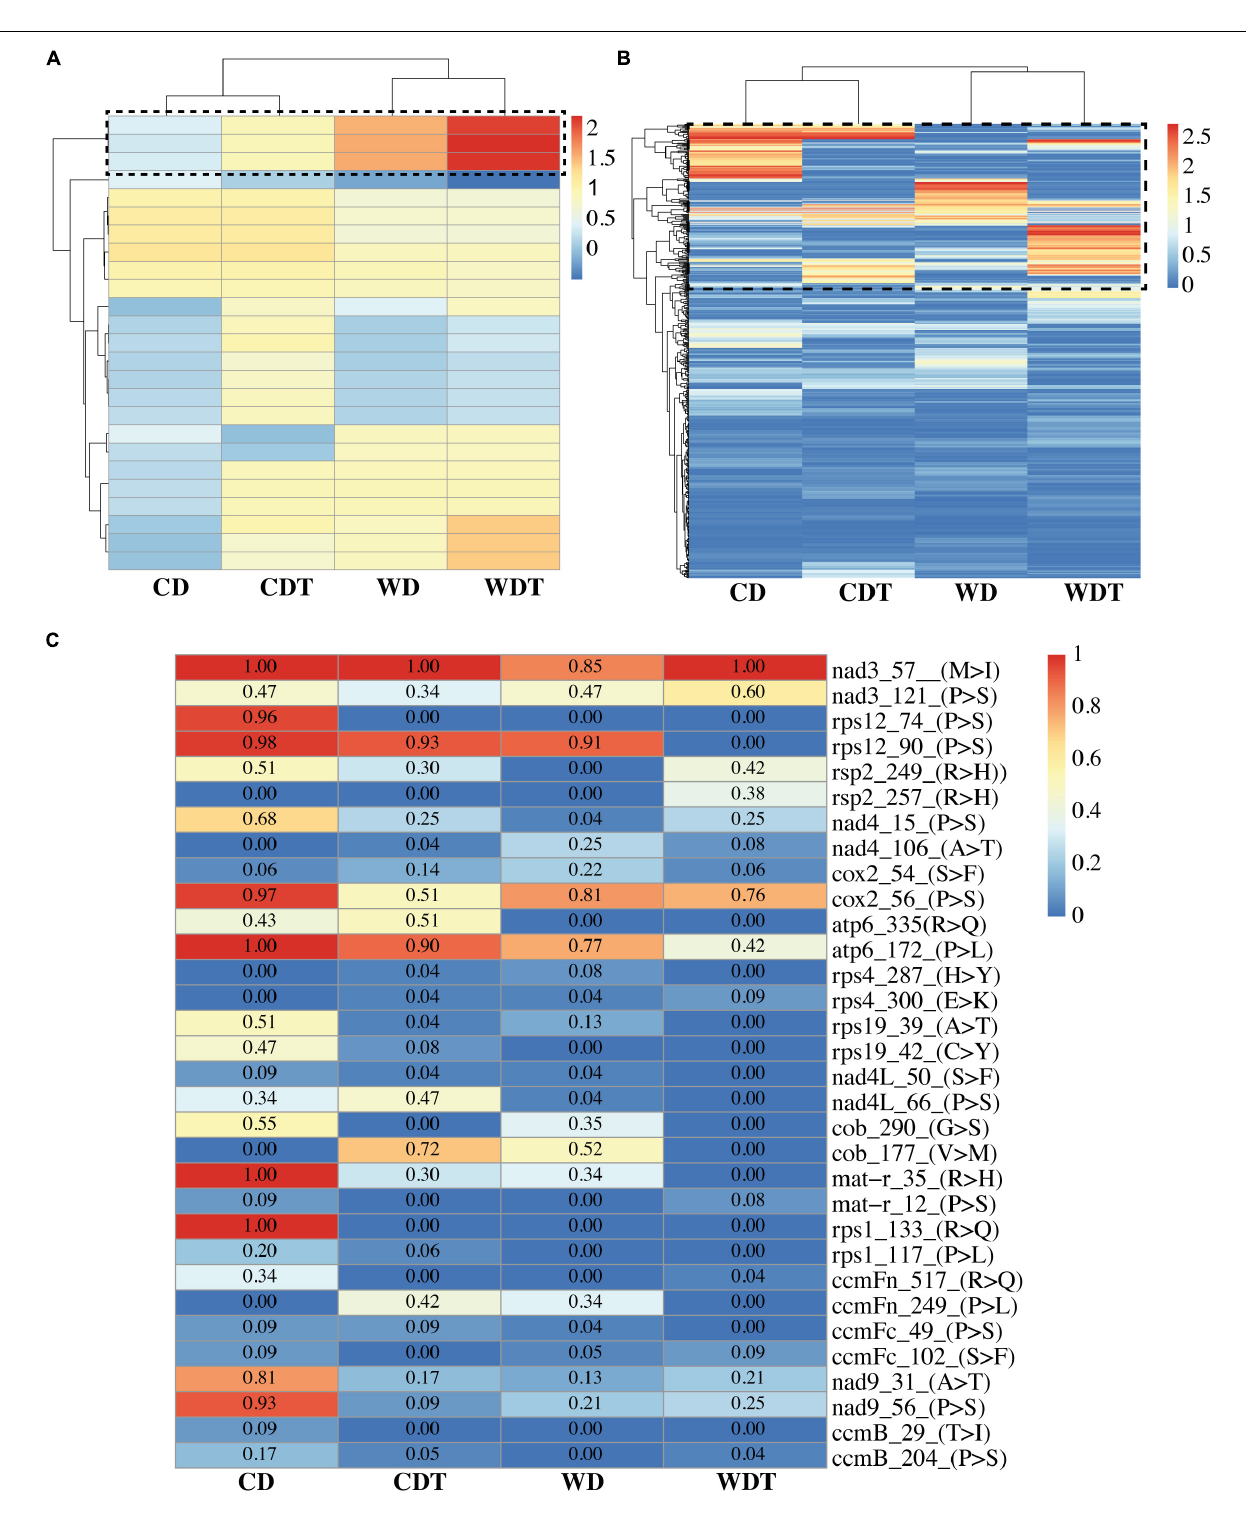
FIGURE 2 | Heatmap of RNA editing efficiency of all the RNA sites in two genotypes of rice (CD, Caidao and WD, WD20342), (A) Chloroplast genome; (B) mitochondrion genome. The x -axis shows the genotypes under control (CD and WD) and treated (CDT and WDT) while the y -axis shows the editing sites. Black dotted box representing the RNA editing sites increased efficiency. (C) Reduced RNA editing efficiency in genes of mitochondria. Values insides the boxes were showing RNA editing efficiency. The x -axis shows the genotypes under control (CD and WD) and treatment (CDT and WDT). Gene names with amino acid position and type of changes were shown on the y